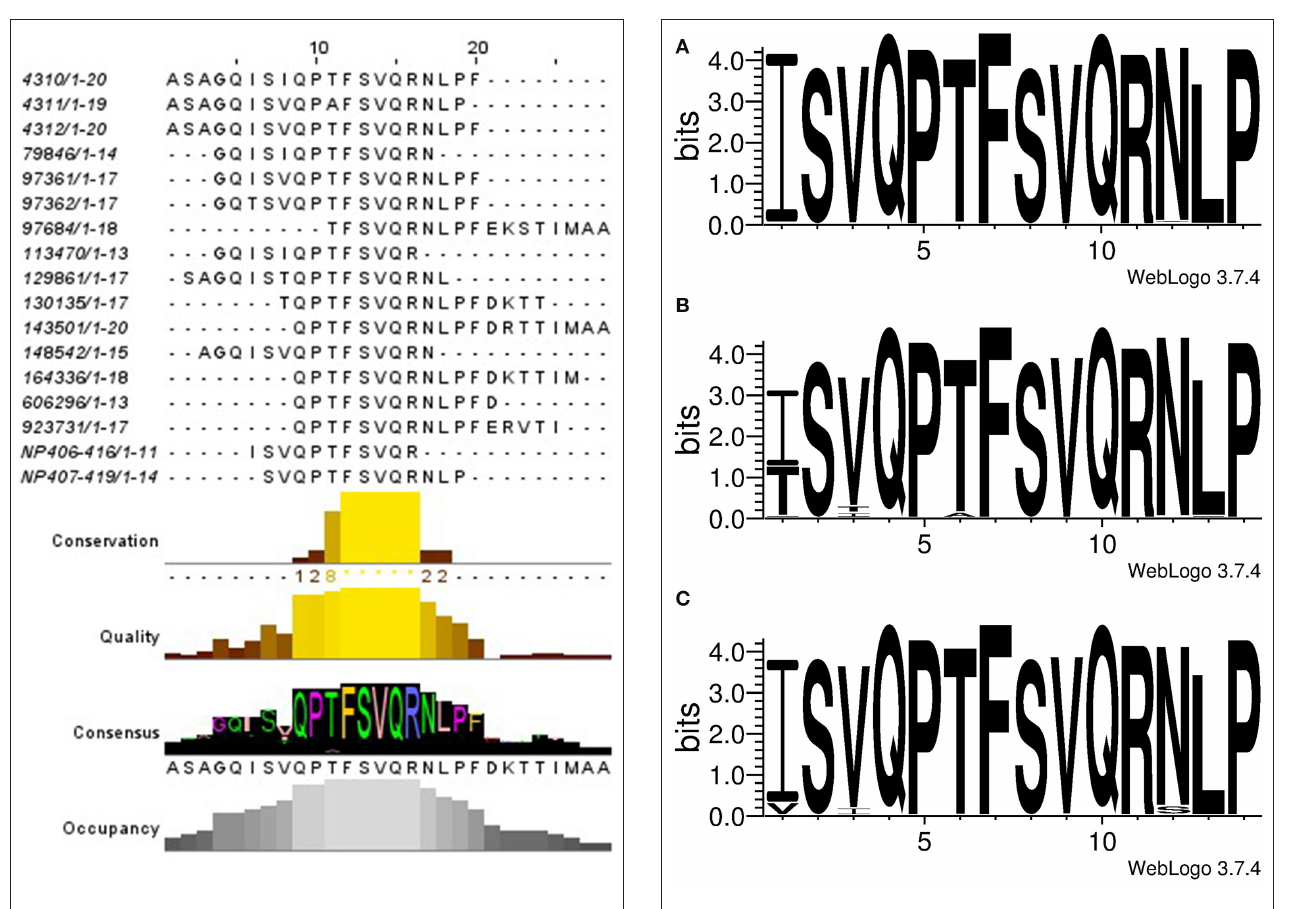
was found in a higher proportion of strains